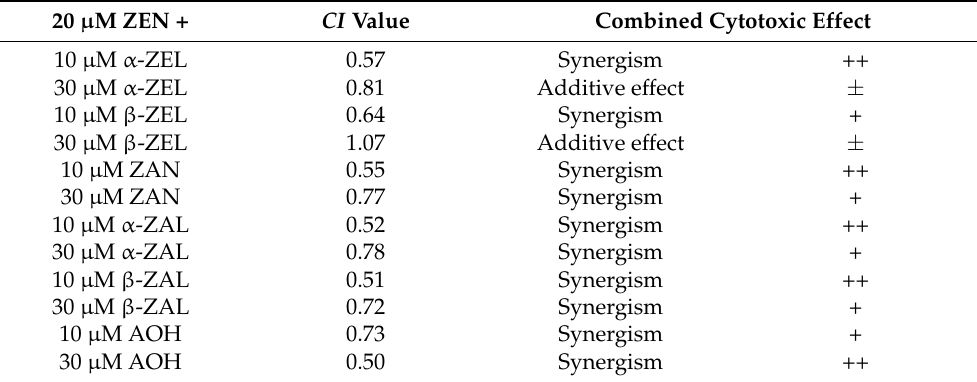
Table 1. The combination index values ( CI < 0.8: synergism; 0.8 < CI < 1.2: additive effect; and CI > 1.2: antagonism) and combined cytotoxic effects of ZEN with cytotoxic concentrations of ZELs, ZAN, ZALs, and